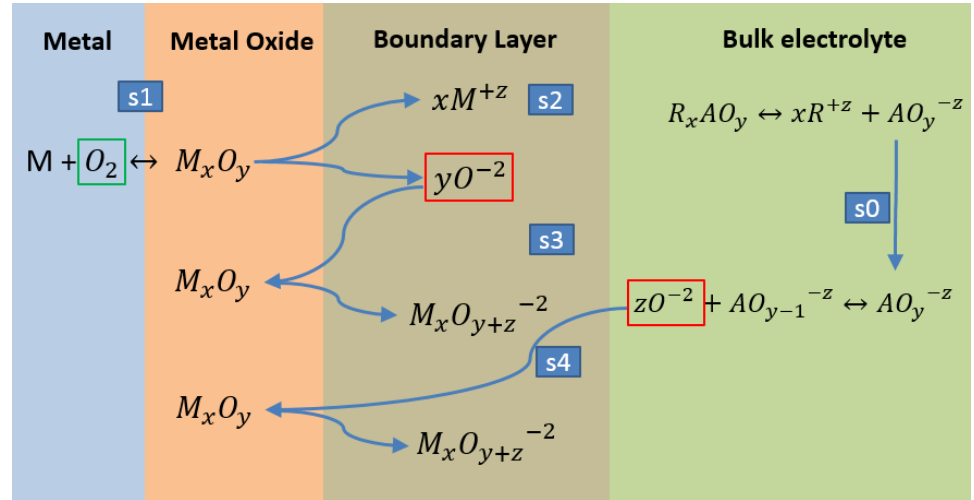
Figure 2. General scheme of corrosion mechanisms on surface metal.